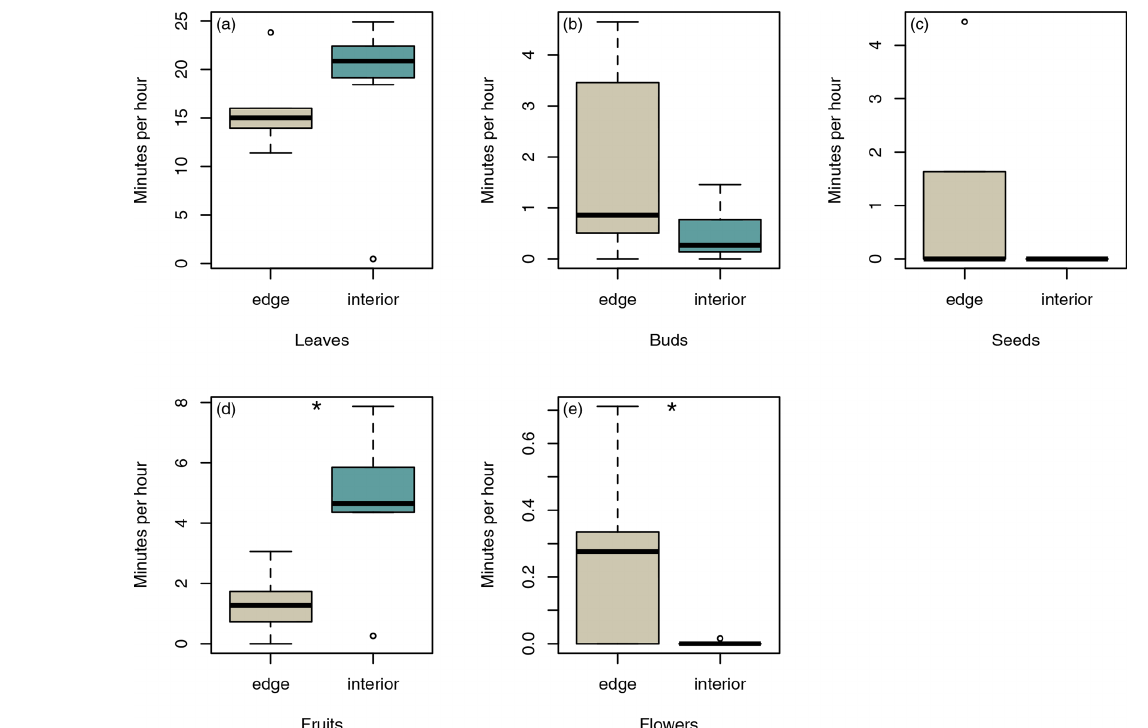
Figure 5. Differences in average time spent feeding on (a) leaves, (b) buds, (c) seeds, (d) fruits, and (e) flowers. Depicted are medians (black horizontal lines), interquartile ranges (boxes), and outliers